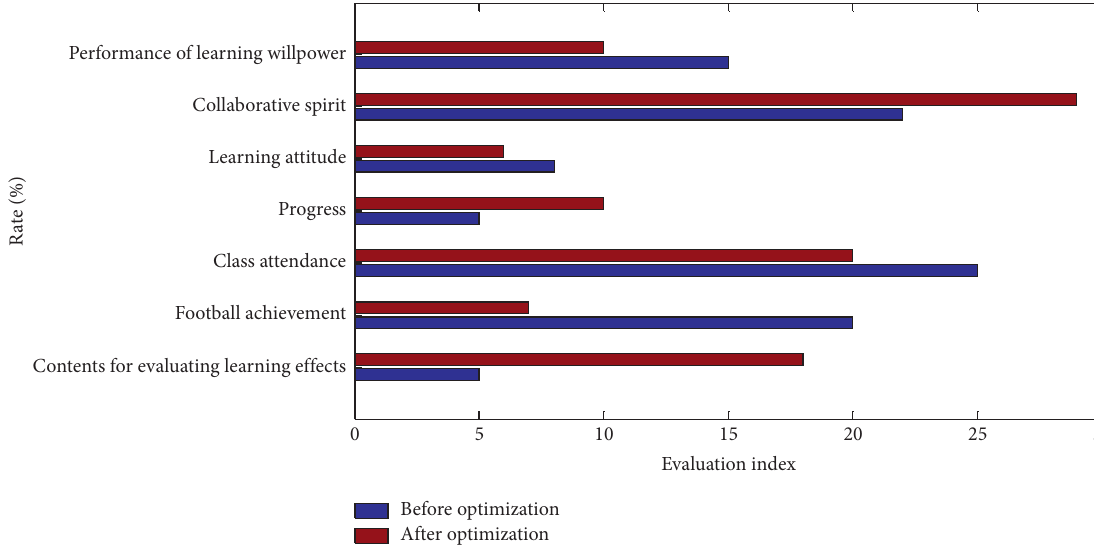
Figure 8: The proportion of students’ evaluation of football teaching effect after the optimization of the football professional teacher teaching evaluation system.